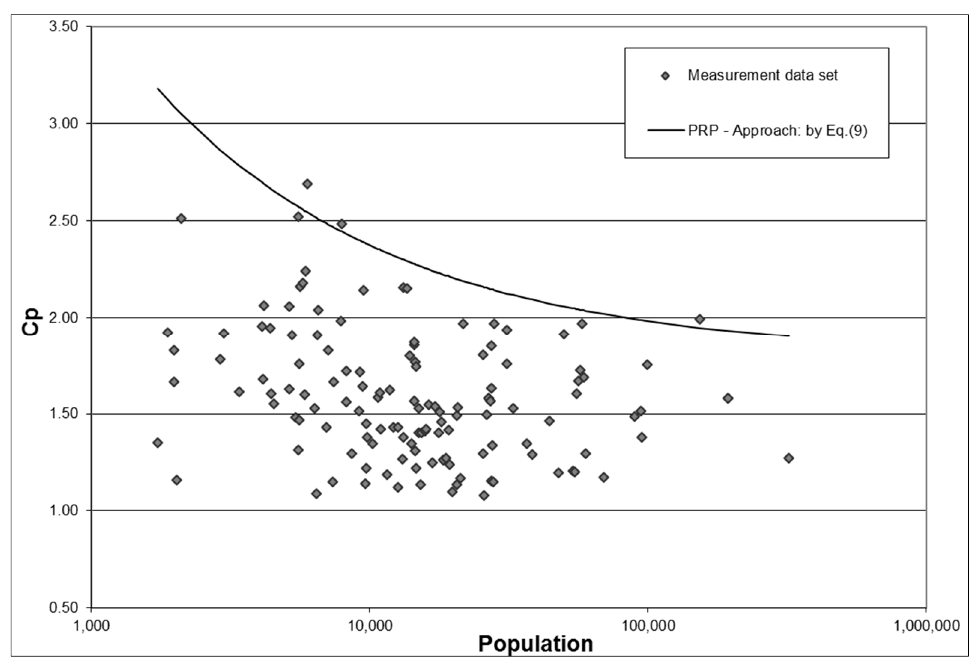
Figure 7. Theoretical relationship curve and measurement dataset depending on the population.